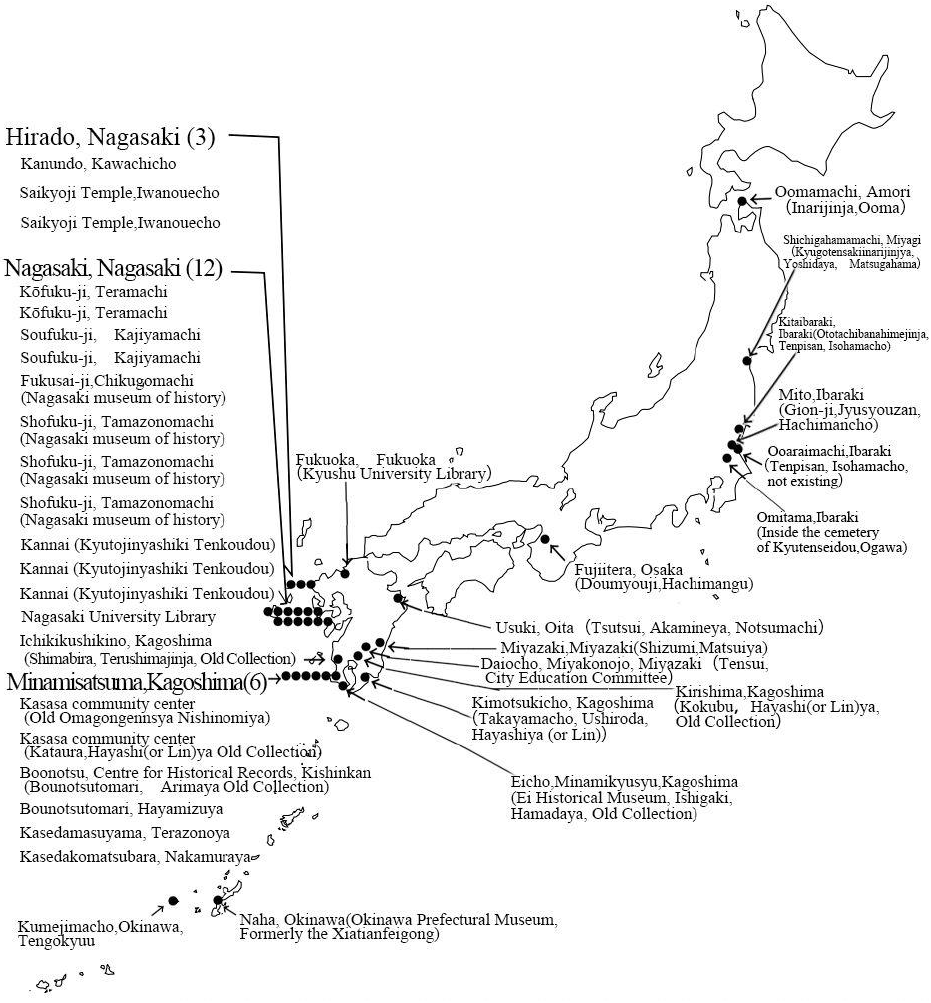
Figure 1. List of ancient Mazu statues in Japan (as of June 2006). Cited in (Takahashi 2009). The belief in Mazu continued northwards along Honshu Island, before settling in the Eastern Japan region. So, what was the reason for the eastern transmission of the Mazu statue? As can be seen in Figure 1, the statues of Mazu are spread all over Honshu Island, reaching not only the northeastern regions of Miyagi and Ibaraki prefectures, but also